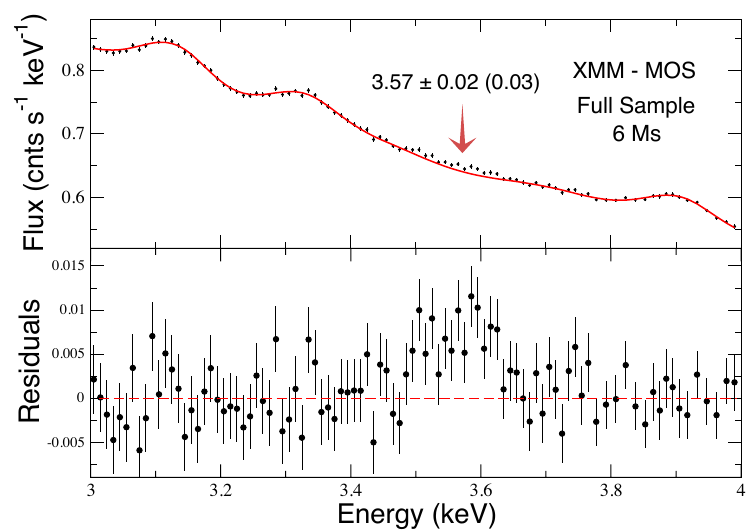
Figure 2: Stacked XMM-Newton spectra from a number of galaxy clusters, leading to the detection of an unexplained feature at around 3.5 keV. Plot taken from [ 10 ]